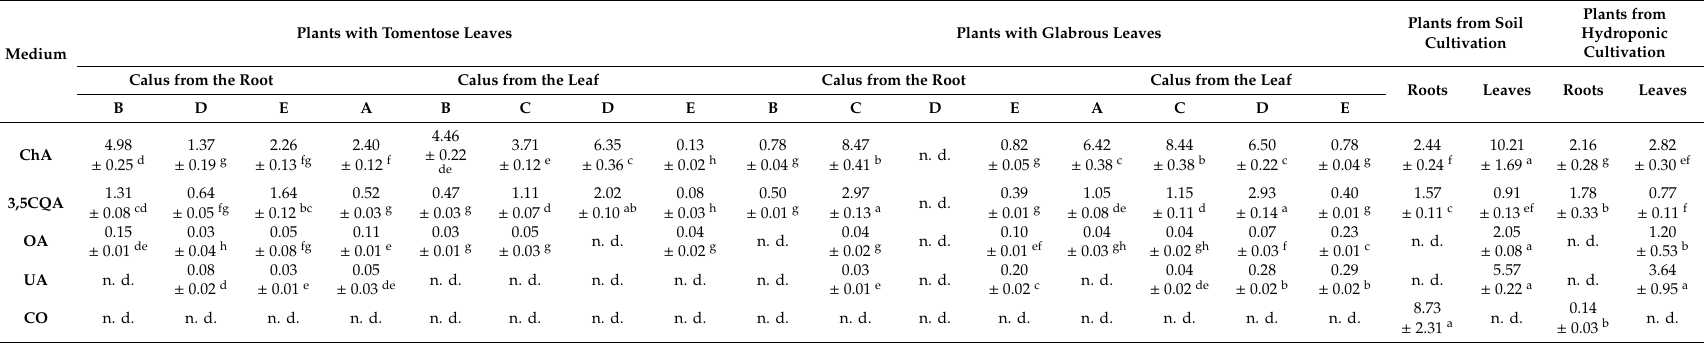
Table 3. Content of determined metabolites (mg · g − 1 dry plant material ± SE) in extracts from the investigated plant materials ( n = 3).